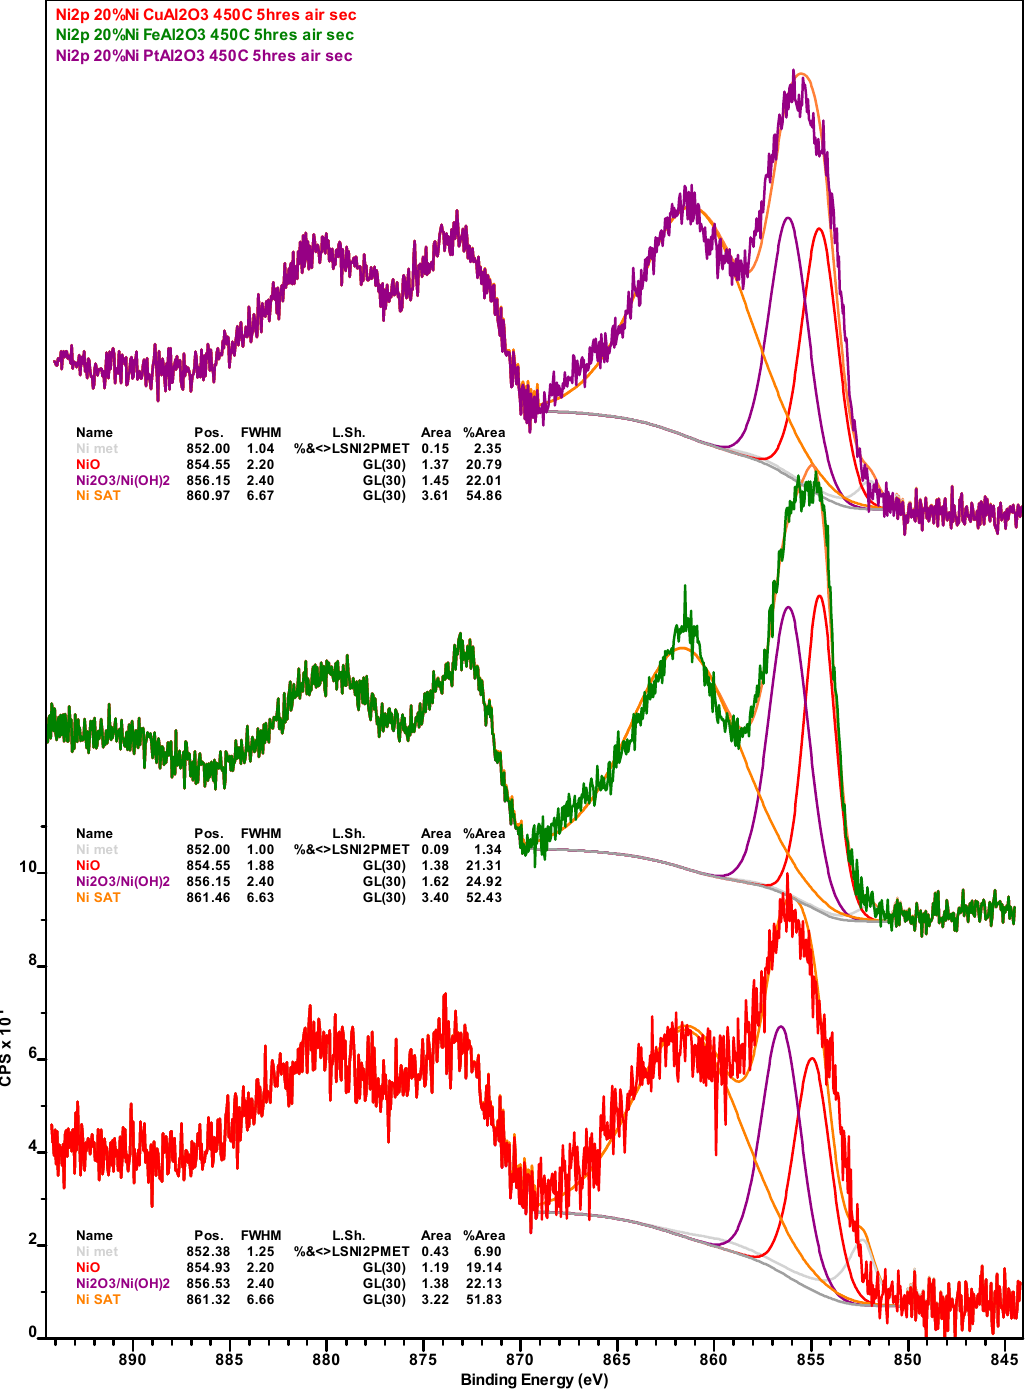
Figure A2. Nickel 2p X-ray photoelectron spectra of the spent Ni-Cu (red spectrum), Ni-Fe (green spectrum), and Ni-Pt (purple spectrum) catalysts recovered from deoxygenation experiments after calcination in air at 450 °C for 5 h.